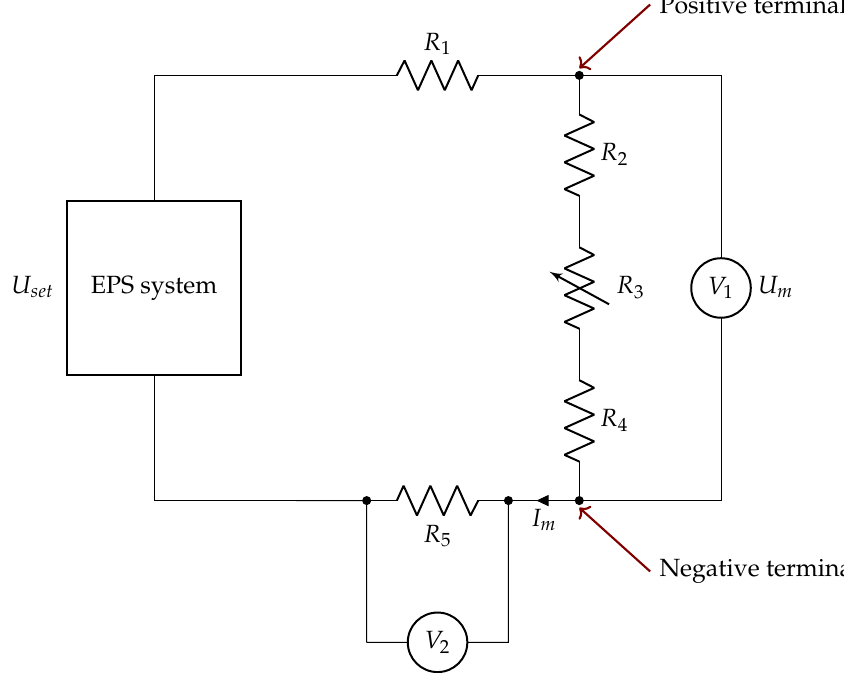
Figure 2. The circuit diagram of the hot-wire system where R 1 is the resistance of the power cables, R 2 is the resistance of the nozzle, R 3 is the resistance of the feedstock wire and the melt pool (process load), R 4 is the resistance of the fixture, R 5 is the resistance of the current shunt, V 1 is the voltage drop between the nozzle and the fixture including the process load and V 2 is the voltage drop over the current measuring